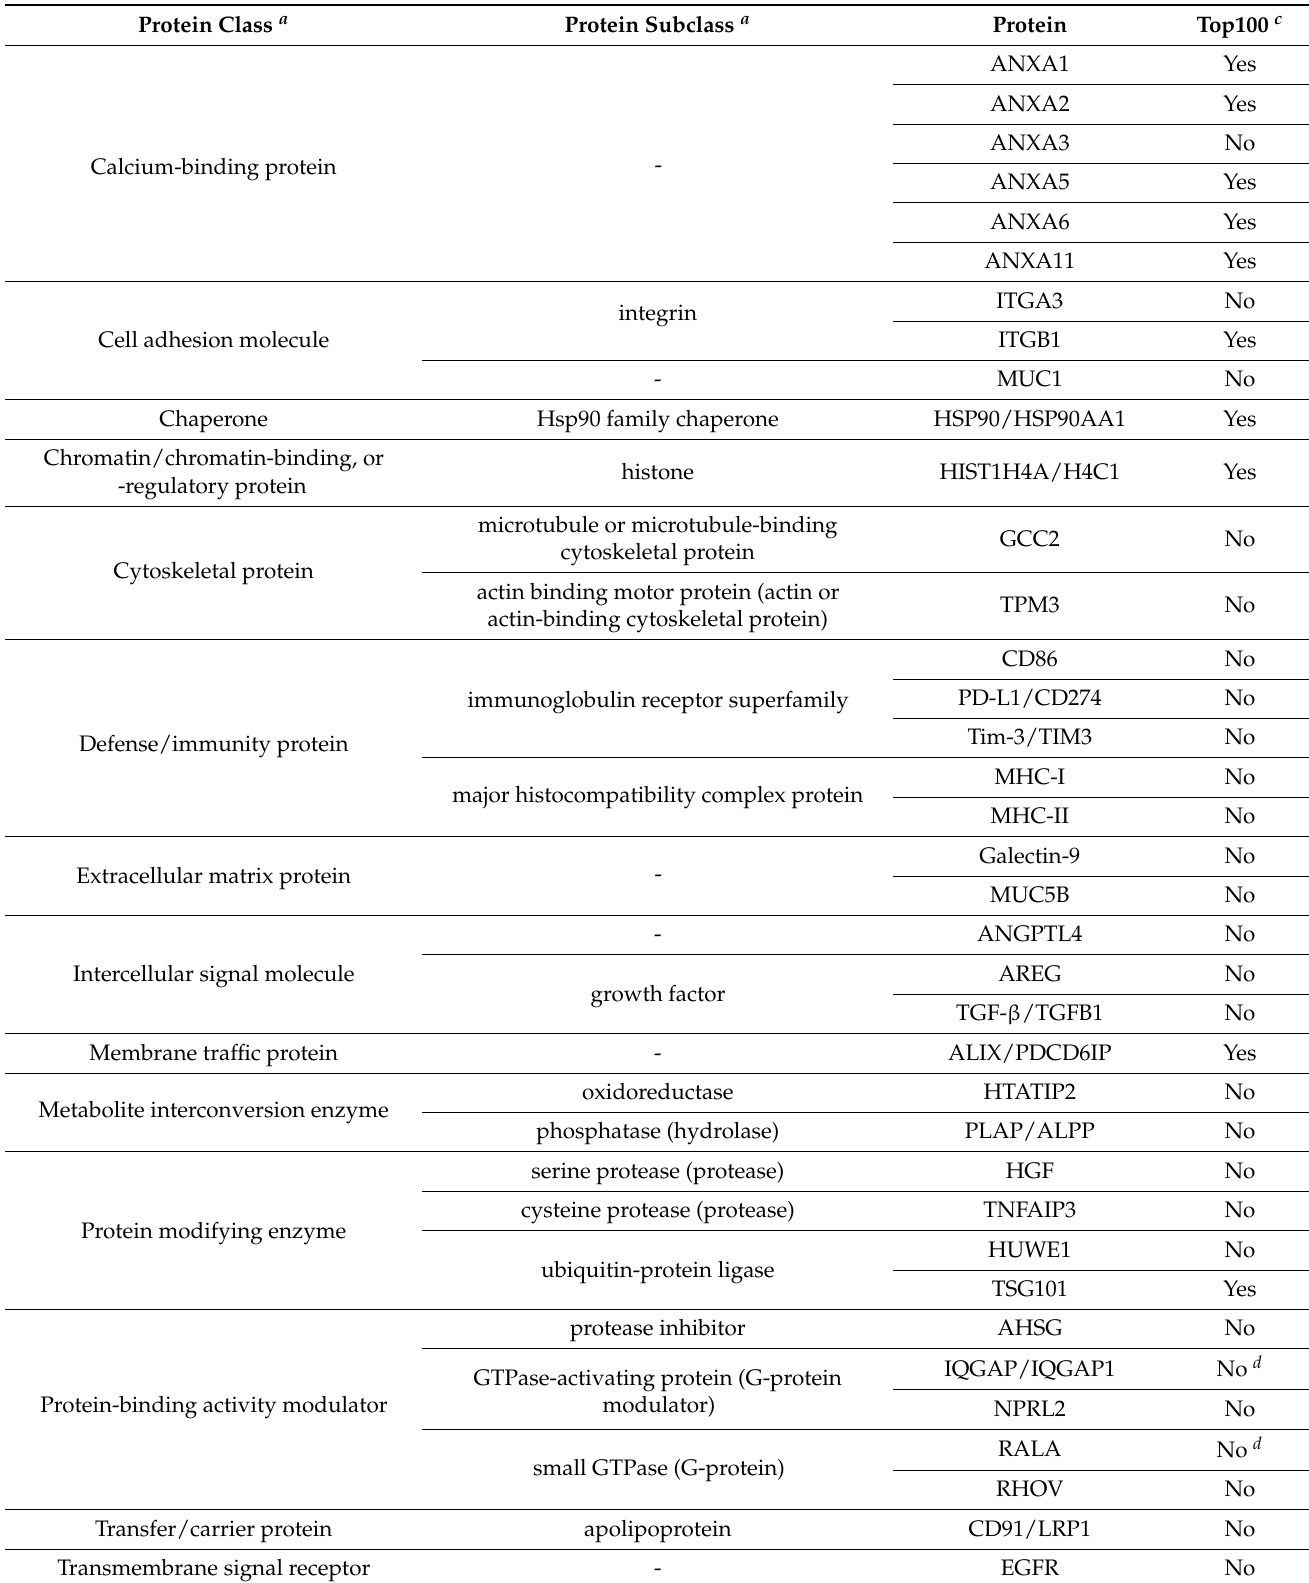
Table 2. Protein, protein class, and subclass of lung cancer